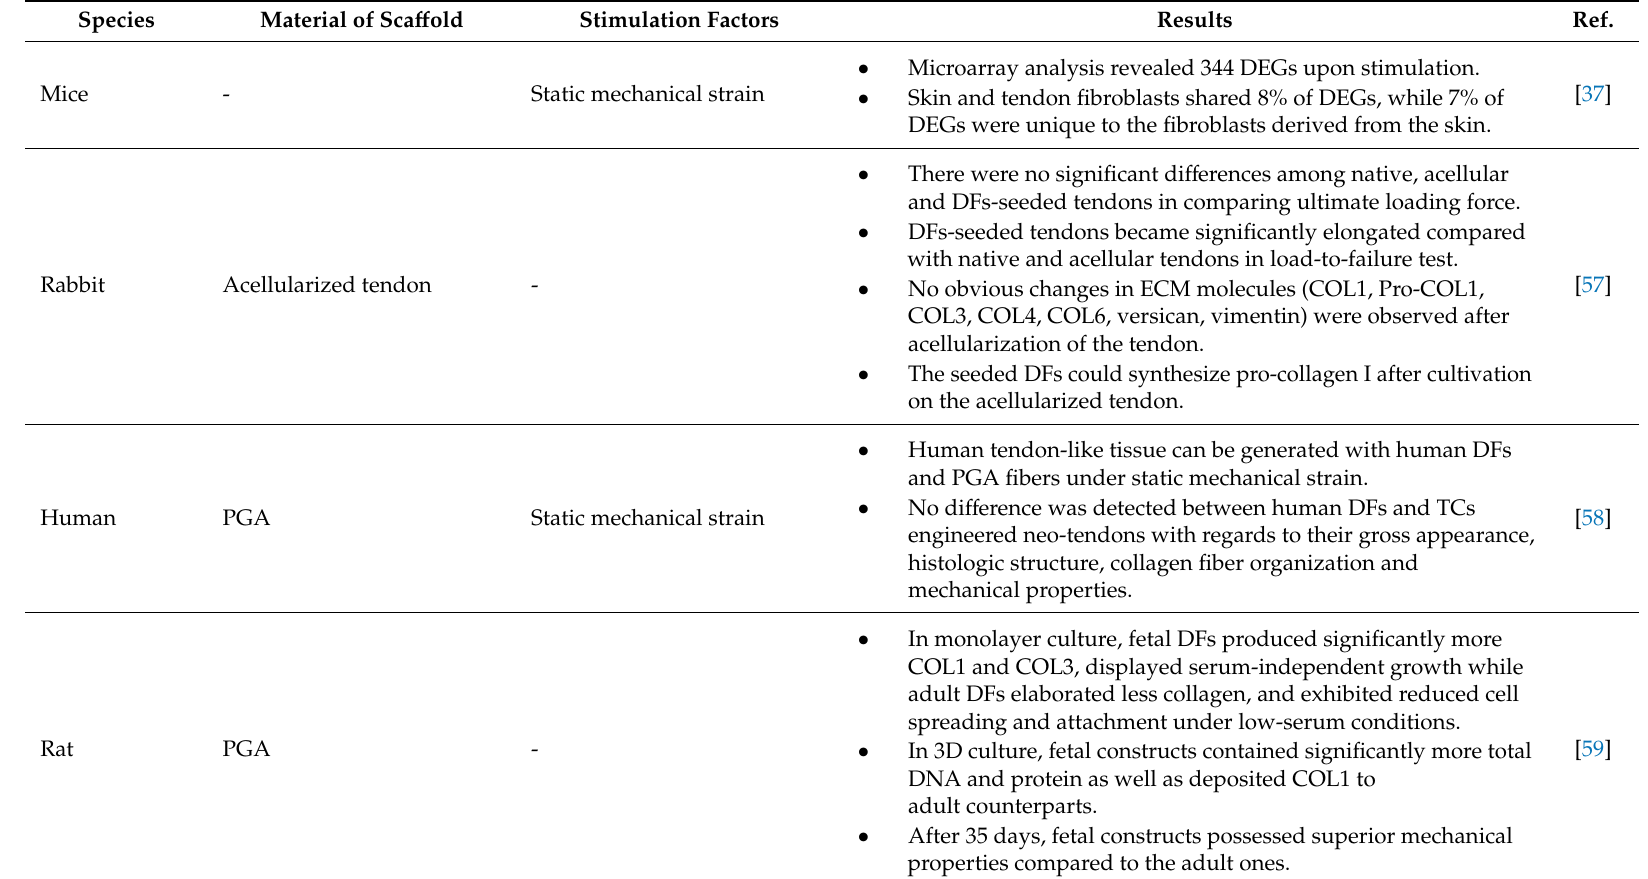
Table 2. In vitro studies on tenogenic potential of DFs (in chronological